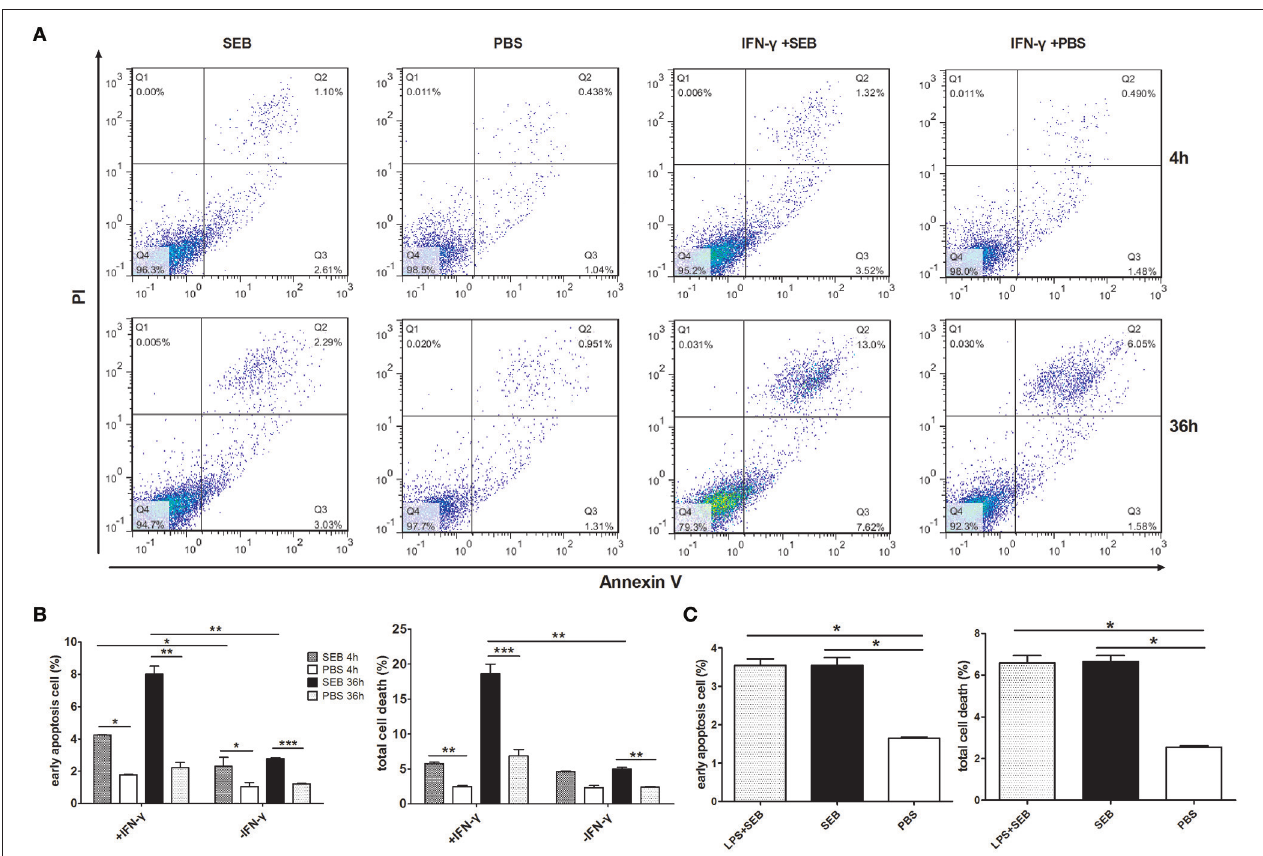
FIGURE 1 | SEB induced THP-1 cell apoptosis even without cell activation. THP-1 cells (2 × 10 5 per well in 24-well-plates) with or without activation of 1 µ g/ml IFN- γ for 24 h were treated with 20 µ g/ml (24 µ l/well) SEB or 24 µ l/well PBS for 4 or 36 h as indicated. (A) Apoptosis were measured by Annexin V/PI staining and flow cytometry. Cells stained with Annexin V + /PI − were considered as early apoptotic cells, and Annexin V + /PI + were regarded as late apoptosis and necrotic cells. Total cell death corresponded to all of the cells positively stained with PI. (B) Quantitatively analyzed data are presented as means ± S.D . ( n = 4), *indicated P < 0.05, **indicated P < 0.01, and ***indicated P < 0.001. (C) Quantitative analysis for THP-1 cells treated with 20 µ g/ml (24 µ l/well) SEB for 36 h, with or without a previous activation by 1 µ g/ml LPS. Data are presented as means ± S.D . ( n = 3), *indicated P < 0.05 vs. PBS